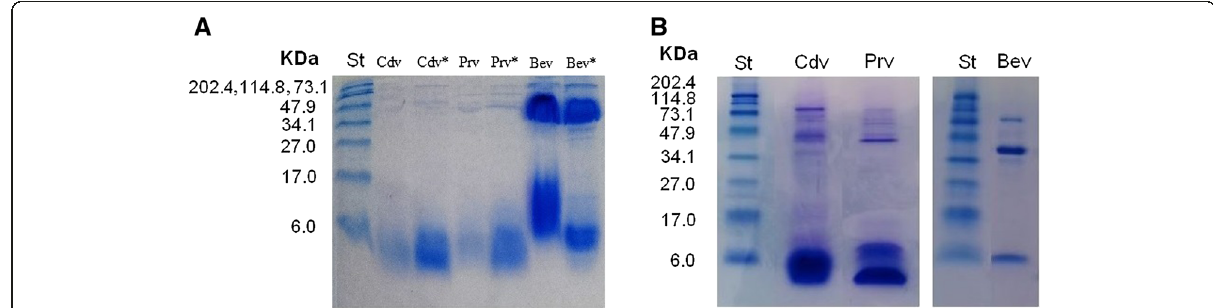
Fig. 5 a . SDS-PAGE gel (18 % acrylamide) showing the protein profiles of P. regalis ( Prv ), C. darlingi ( Cdv ) and B. epicureanum ( Bev ) venoms. Prv*, Cdv* and Bev* correspond to the venoms under reducing conditions. b . SDS-PAGE gel (14 % acrylamide) showing the protein profiles of the venoms under reducing conditions. The protein profiles were compared with a broad-range polypeptide standard ( St ), and the masses of the molecular weight markers (in kDa) are shown on the left of the gels. Protein bands were visualized with Coomasie